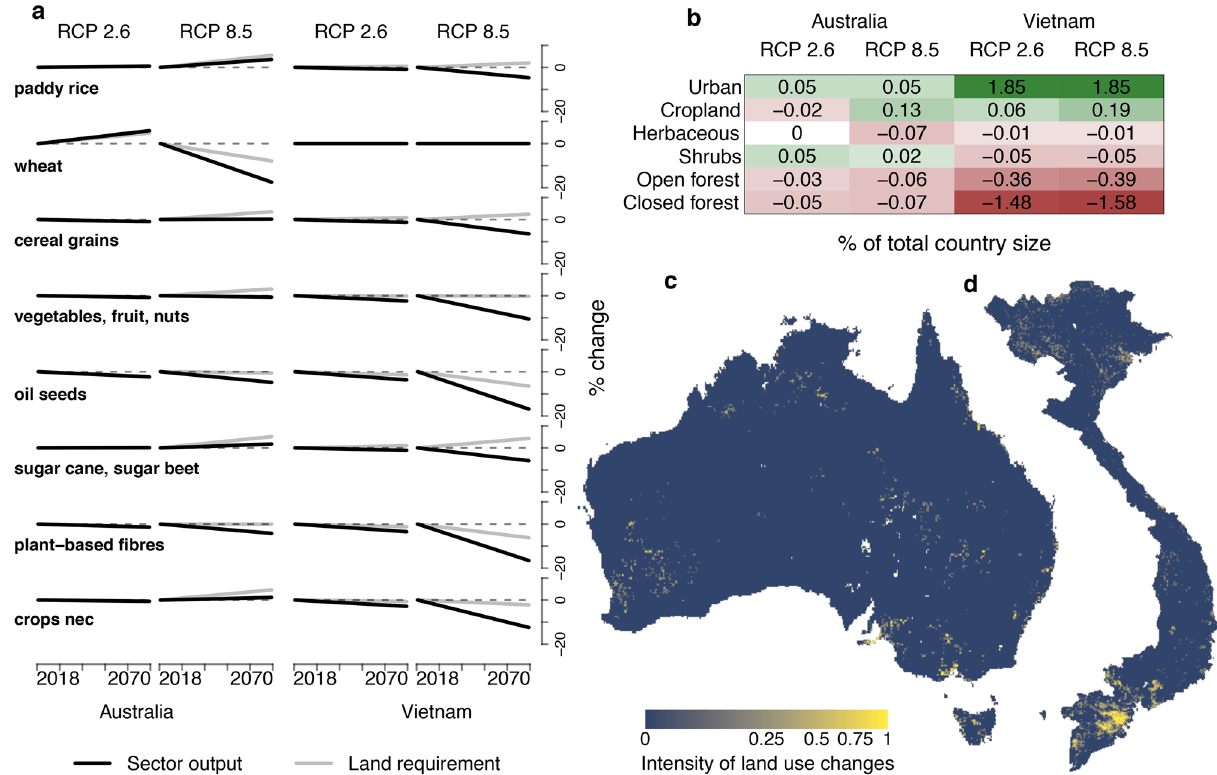
Figure 3. CGE and land use model results. ( a ) Future projections of commodity sector output and sector land endowments (the area required to produce output of a sector) from CGE model under RCP 2.6 and RCP 8.5. ( b ) Illustration of the percentage change of each land use in response to GTAP projections of crop sectors in ( a ) and FAO urban population projections, grouped by country and RCP, relative to the whole country size. ( c , d ), Intensity of predicted land use changes under indirect effects of RCP 8.5 in ( c ) Australia and ( d ) Vietnam. These maps are derived by aggregating predicted land use changes between any two classes under the indirect impacts of RCP 8.5 by factor 3. Figure created in R version 3.5.1 27 (https ://www.R-proje